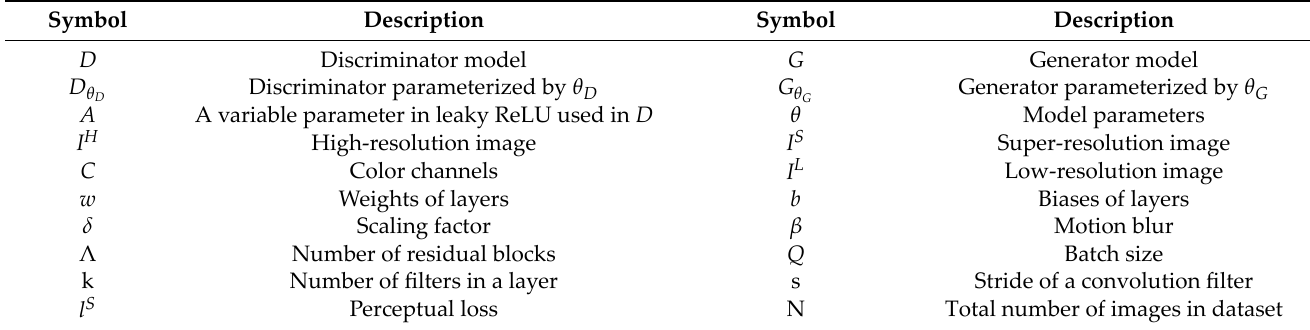
Table 1. Description of input and output parameters used in the proposed